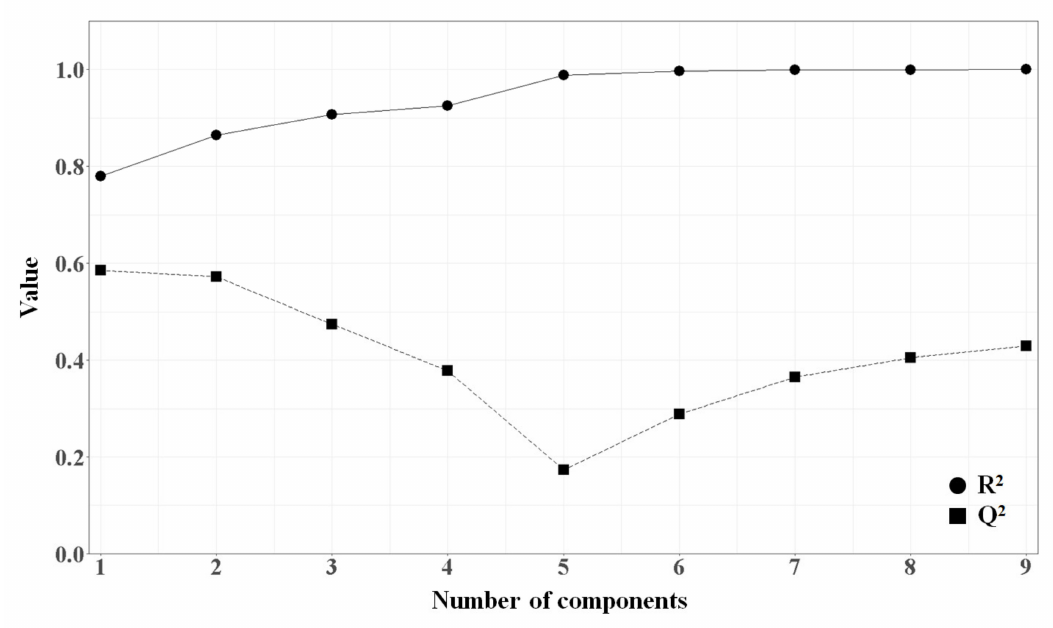
Figure 7. Plot of R 2 and Q 2 versus the number of